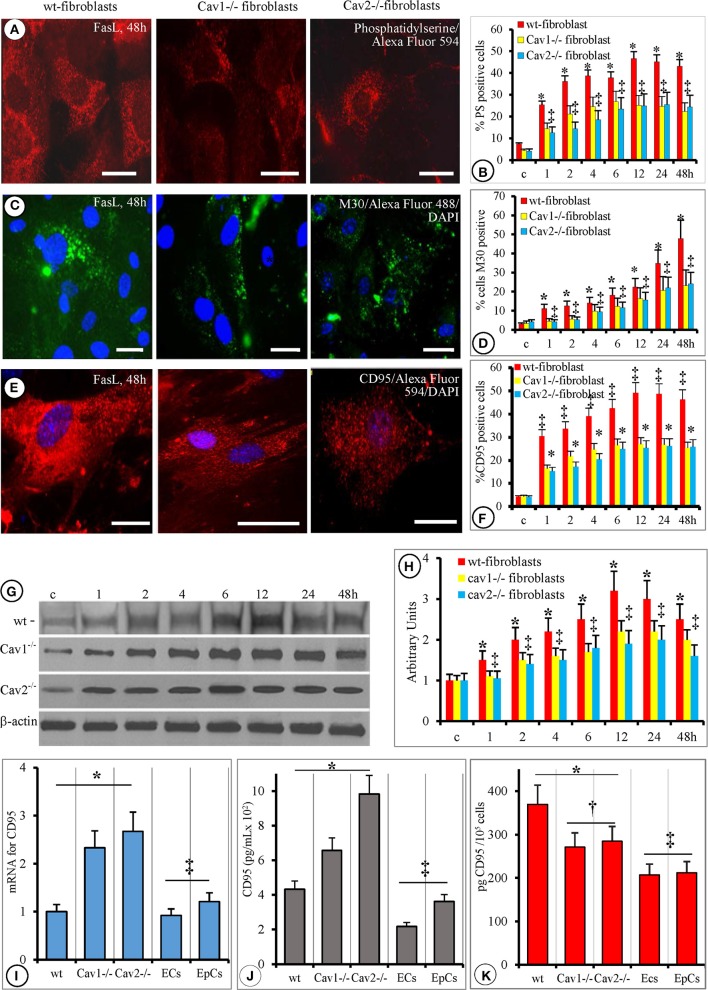
Phosphatidylserine, M30 and CD95 alterations are similar in cav-null and wt-fibroblasts but with a distinct temporal manifestation. (A) Representative Annexin V staining of mouse fibroblasts (wt-, Cav1−/−, Cav2−/−, as indicated) demonstrates the presence of PS on the external leaflet of the plasmalemma proper after FasL stimulation; the images are representative for mice fibroblasts isolated at 4 months old. Note the decreased fluorescence displayed by Cav-null fibroblasts. Bars: 25 μm, n = 7. (B) Quantitative assessment of PS-positive cells on 70 ROIs, collected from six different experiments for every type of fibroblasts; *p < 0.05 Cav-null vs. wt-fibroblasts, while no statistical differences (‡p < 0.22) were found between Cav1−/− and Cav2−/− fibroblasts; (C) demonstrative images demonstrating the presence of M30 antigen, at 48 h, after FasL treatment in fibroblasts isolated from 4 months old mice. Bars = 20 μm, n = 6. (D) Quantification of M30-positive cells on 45 ROI for every type of fibroblast. Analysis of M30 presence did not reach statistical significance between Cav1−/− and Cav2−/− fibroblasts; ‡p < 0.31, but it was significant when wt-fibroblasts are compared to control (untreated) cells, *p < 0.05; n = 6 for every time point and cell type. (E) CD95/FasL presence on fibroblasts isolated from 4 months old mice revealed the same pattern of its surface distribution (scattered immunoreactive puncta) on all types of fibroblasts. Bars: 25 μm, n = 8. (F) Semi-quantitative evaluation (percentage of CD95/FasL immunoreactive cells out of the total number of cells) performed on 55 ROI, for each type of fibroblasts, over time reveals that the only significant difference was between wt- and cav null fibroblasts (*p < 0.05) and among the untreated (control) and FasL-treated fibroblasts. (G) WB analysis of Fas bound to the membrane fraction shows fluctuation on the amounts over a 48 h FasL treatment; n = 4 for every type of fibroblast and time point and the experiments were repeated three times. The graph on (H) shows the quantitative aspect of membrane bound Fas, and points to the fact that there is no statistical significance between wt and cav-null fibroblasts, p < 0.25 as well as between Cav1−/− and Cav 2−/− fibroblasts, p < 0.3. (I) qPCR evaluation of mRNA for CD95/FasL showing that Cav-null fibroblasts synthesize more CD95 than wt-, ECs, and EpCs, n = 6, p < 0.05, while no statistical significance was detected between ECs and EpCs, p < 0.25. (J) ELISA quantification of soluble form of CD95/FasL (released into culture media) indicating that the fibroblasts secrete more CD95 than the lung ECs and EpCs. n = 8, *p < 0.01 when fibroblasts are compared to ECs and EpCs and ‡p < 0.05 between different types of fibroblasts. (K) Cell surface expression of CD95 as detected by cell ELISA demonstrated its presence at a higher levels in all fibroblasts than in the ECs and the EpCs, *p < 0.05; the fact that are no significant differences in FasR amounts between ECs and EpCs, ‡p < 0.27 and the finding that the surface CD95 was less in Cav-null fibroblasts than in the wt-fibroblasts, ‡p < 0.02.